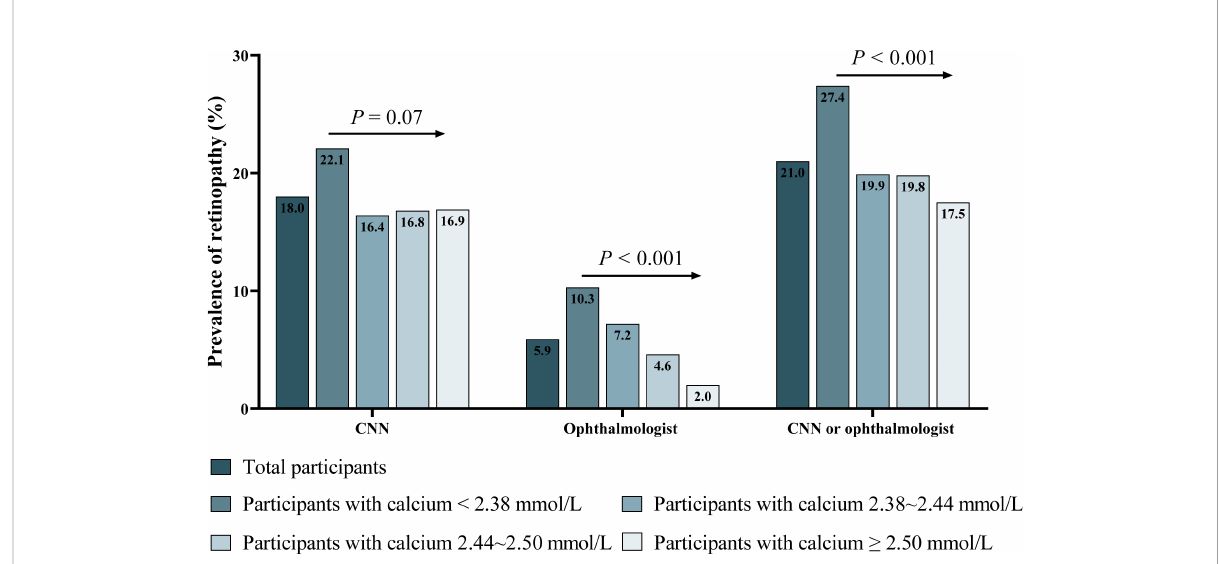
FIGURE 2 Prevalence of retinopathy discerned by CNN, ophthalmologist, and by either CNN or ophthalmologist. CNN, convolutional neural network. P : P for trend tested by chi-square test for